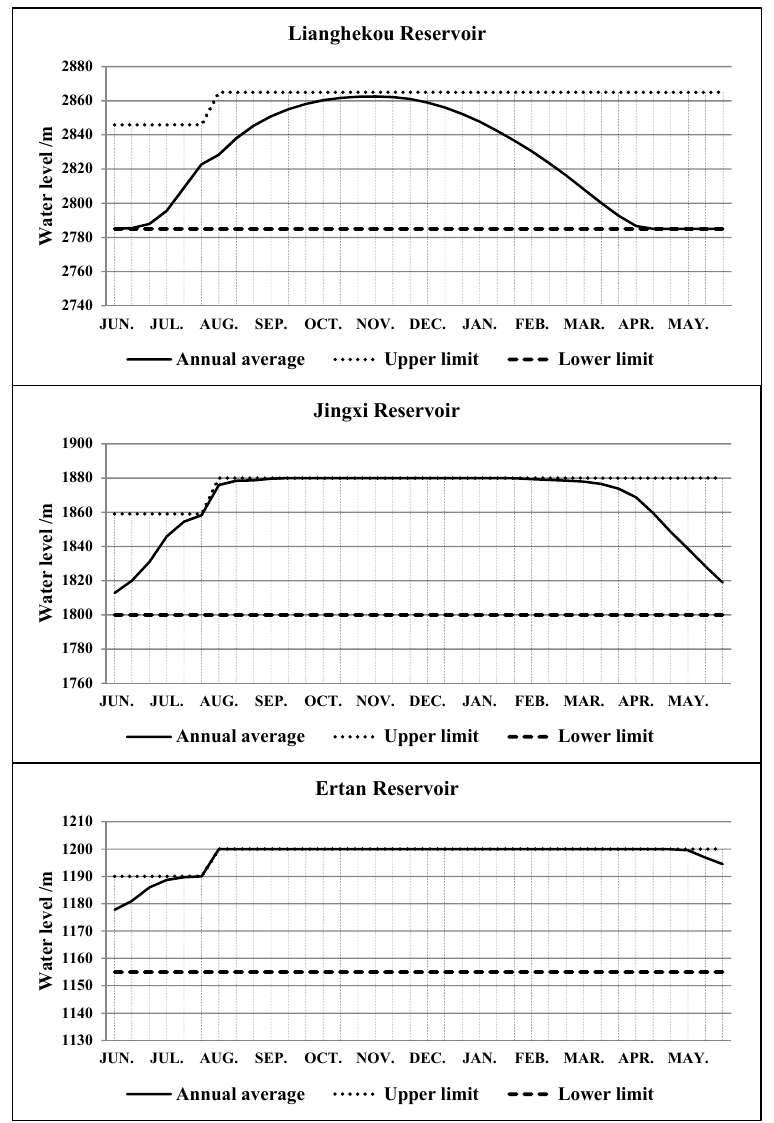
Figure 10. Multi-year average water level process of the three regulating reservoirs.